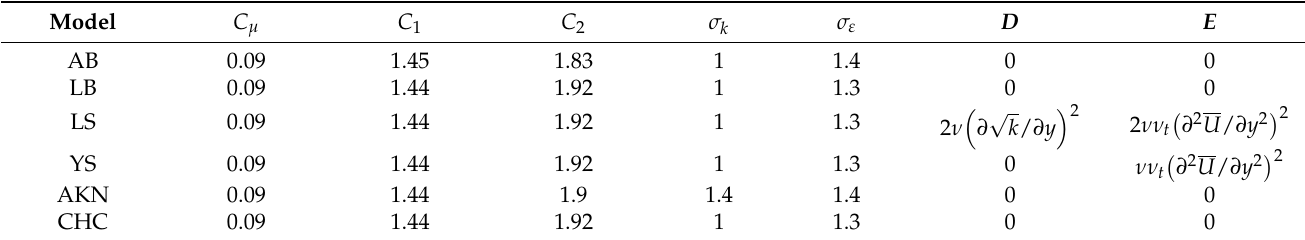
Table 1. Model constants and extra terms in governing equations.